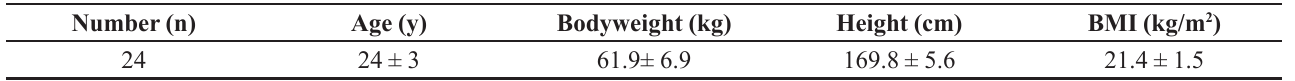
TABLE I - Summary of demographic data